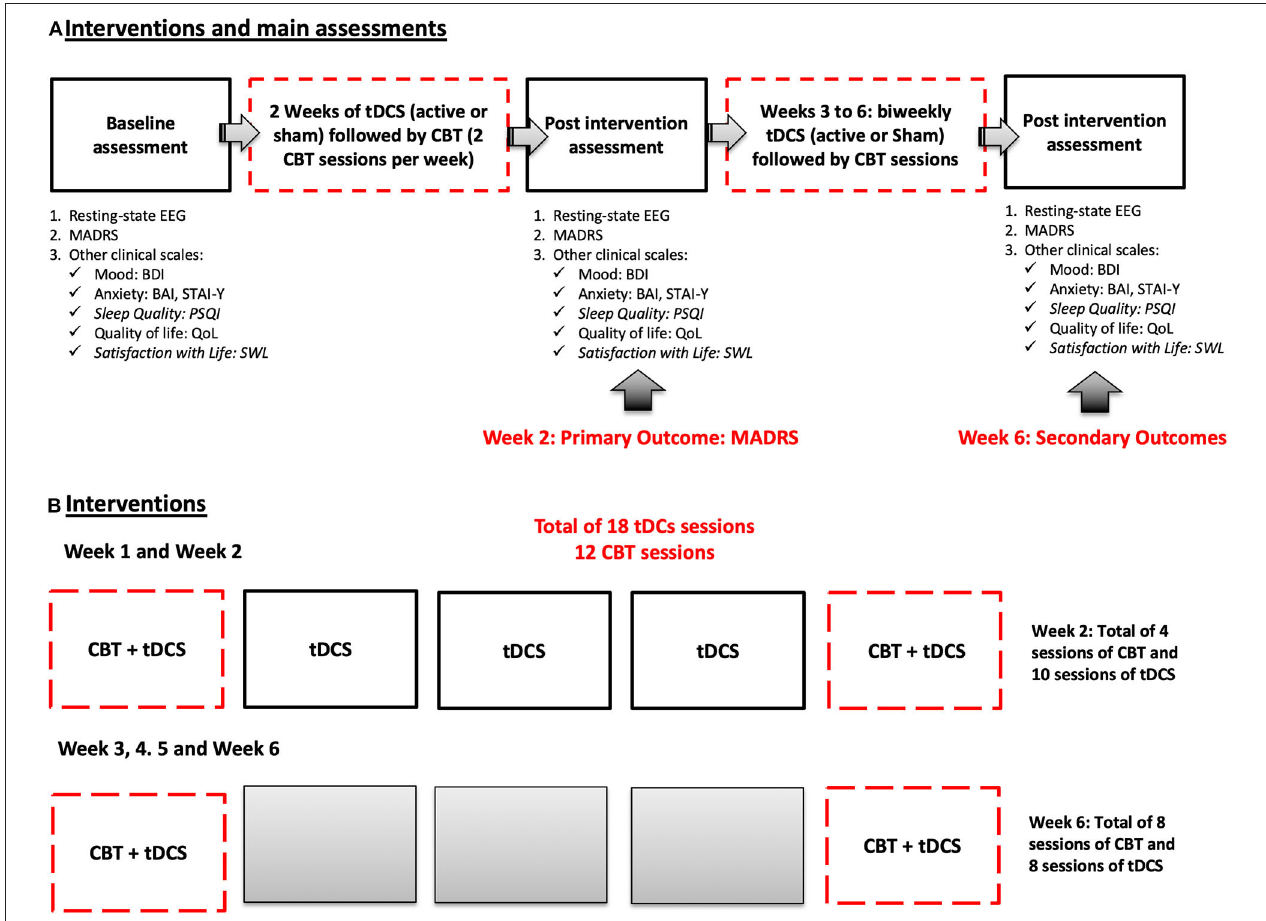
FIGURE 2 | Schematic representation of the main phases of the trial. (A) Shows the timeline of assessments. (B) Details how interventions sessions will be administered by